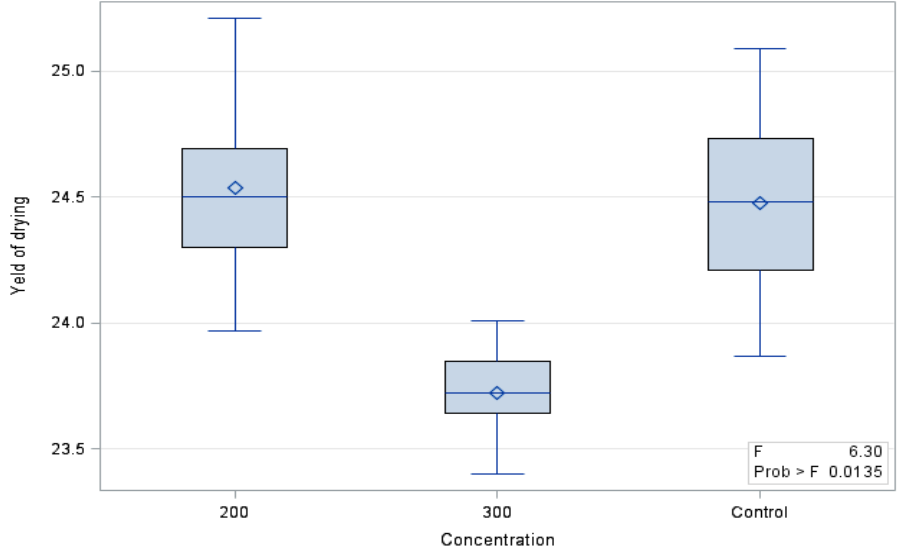
Figure 1. Drying efficiency of ‘Einset Seedless’ fruit.